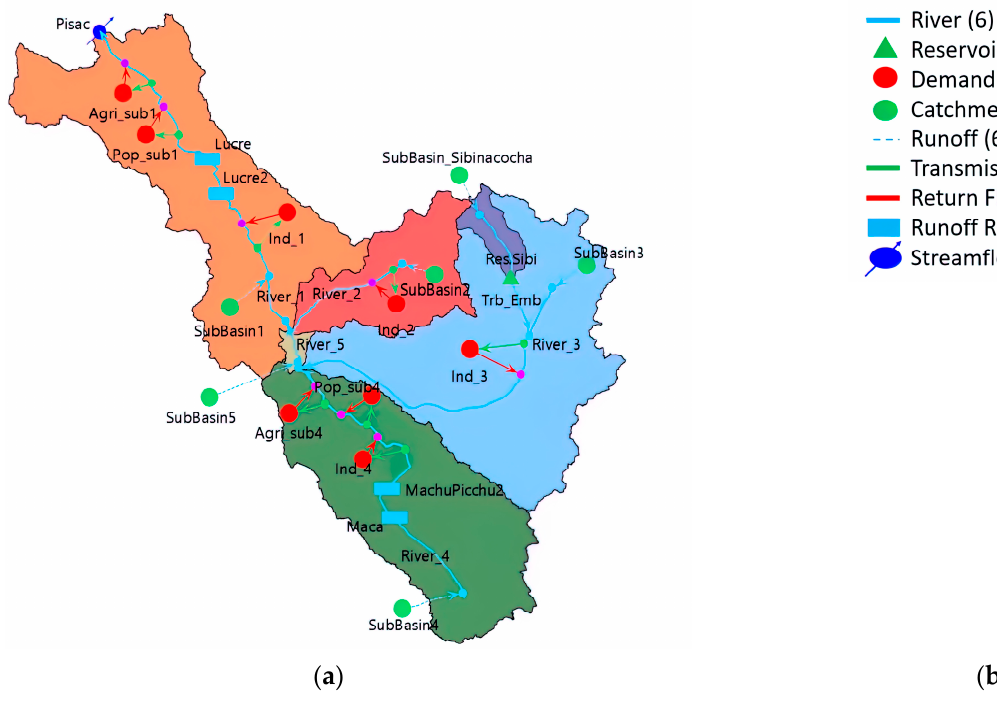
Figure 5. ( a ) Schematic of the VUB region in the WEAP model. ( b ) Legend.